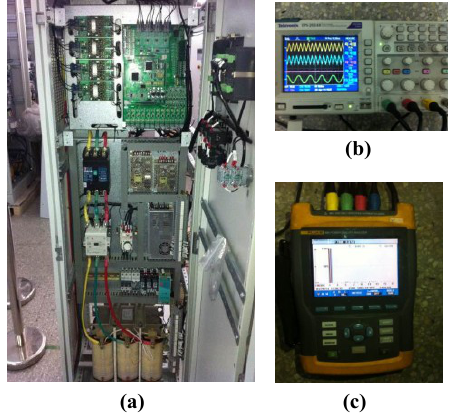
Figure 12. Experimental platform and measurement instruments.